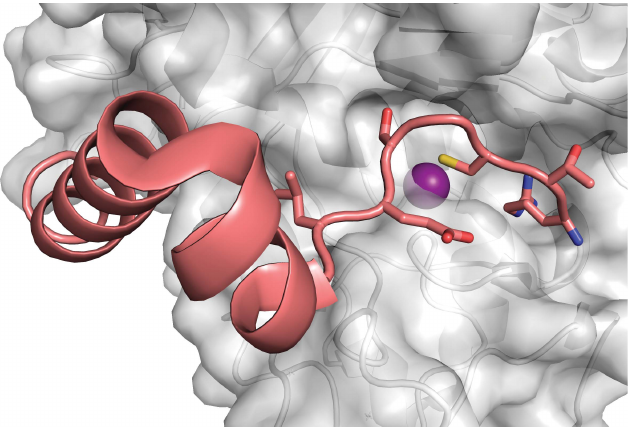
Figure 1 Structure of promirolysin reveals how the pro-segment inhibits enzyme activity prior to proteolytic activation. The N-terminal residues of the pro-segment (salmon) occupy the active site cleft of the catalytic domain (gray), with a key cysteine residue coordinating the catalytic zinc ion (purple). This figure was generated using Pymol from the coordinates of PDB structure 6r7v, reported in this issue by Guevara, Rodriguez- Banqueri et